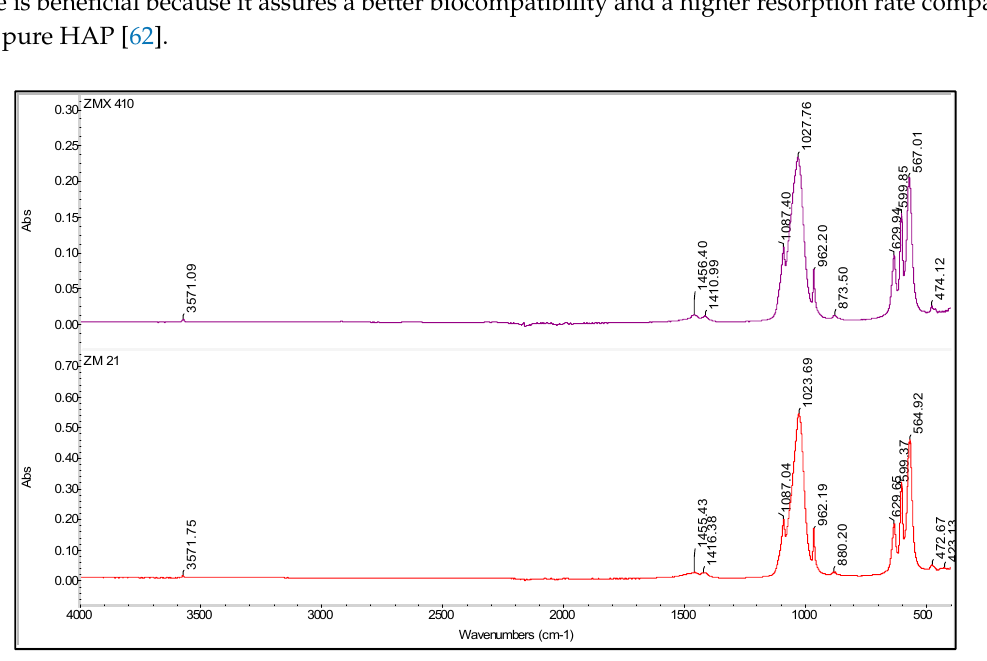
Figure 7. FTIR spectra of the coated ZM21 and ZMX410 samples.